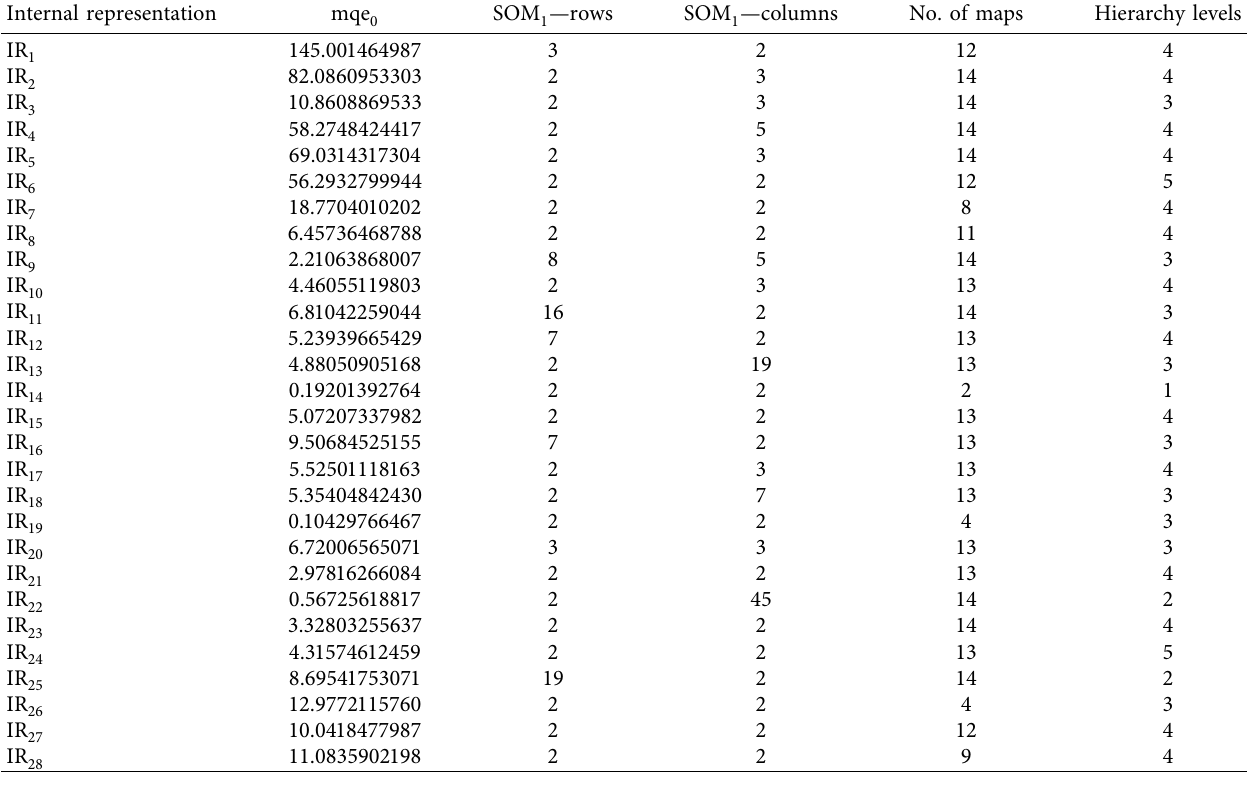
Table 2: GHSOM results based on internal representations.